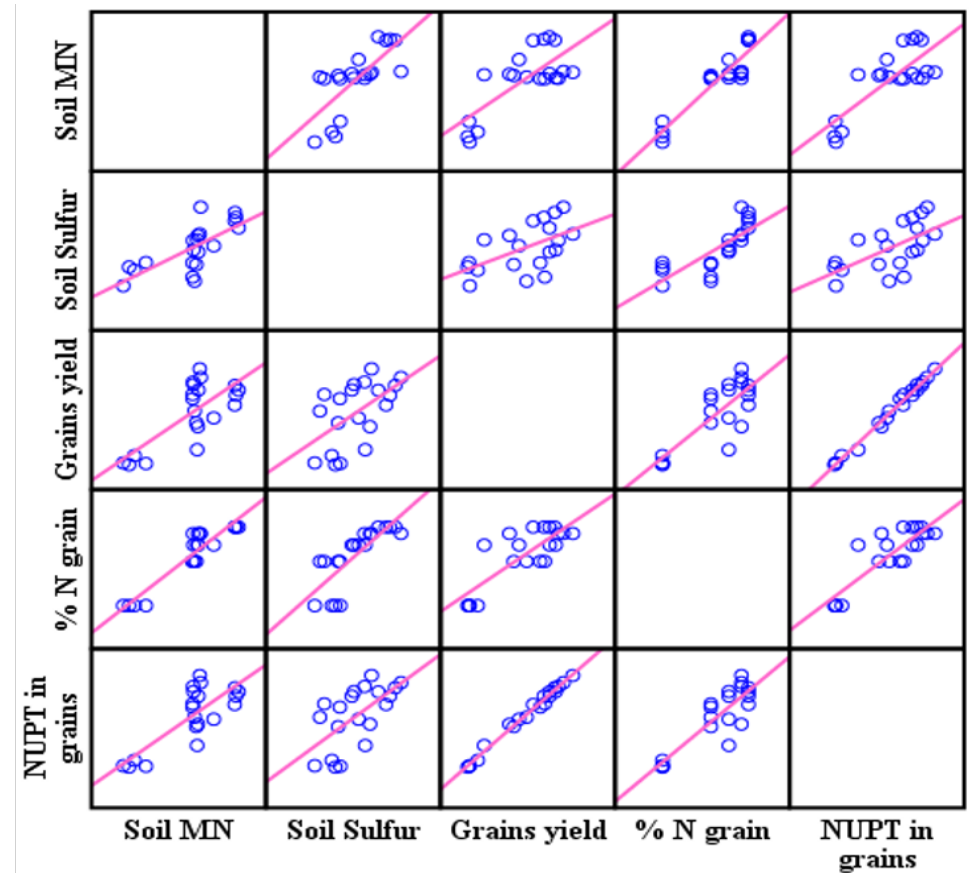
Figure 6. The correlation matrix relations effect of soil mineral N and sulfur on the N uptake in the grains, the grain’s total N, and the grain’s yield in 2018.